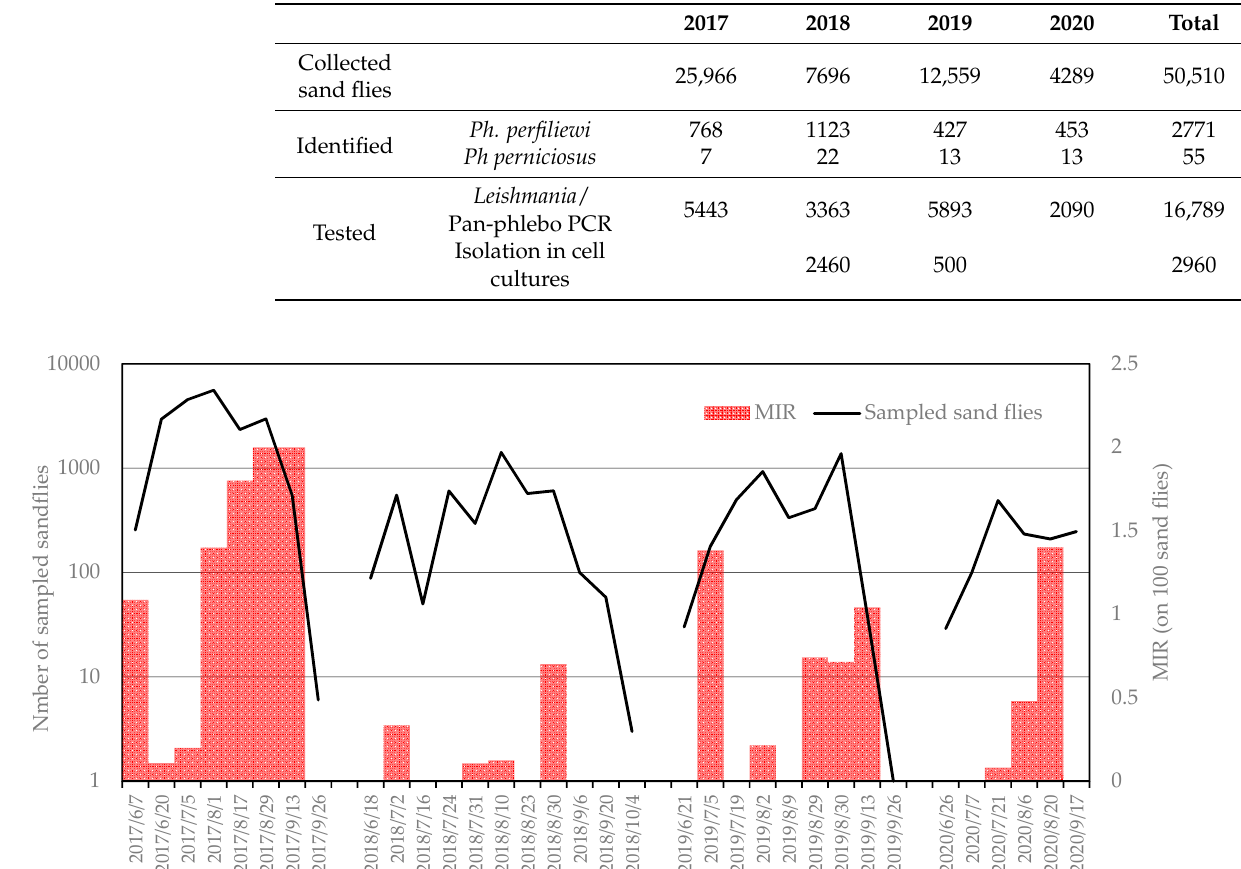
Figure 1. Number of sand flies sampled per night per trap (logarithmic scale) with reference to the Leishmania minimum infection rates per 100 specimens.